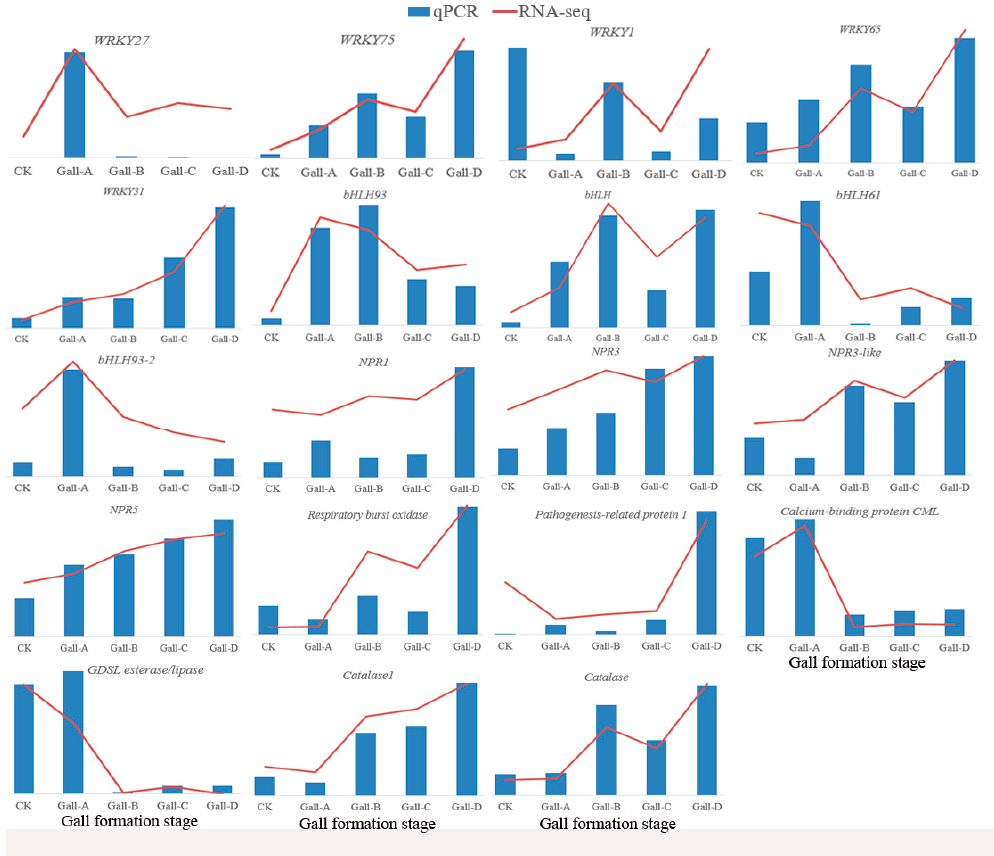
Figure 9. Conformation of the RNA-seq data by qRT-PCR.